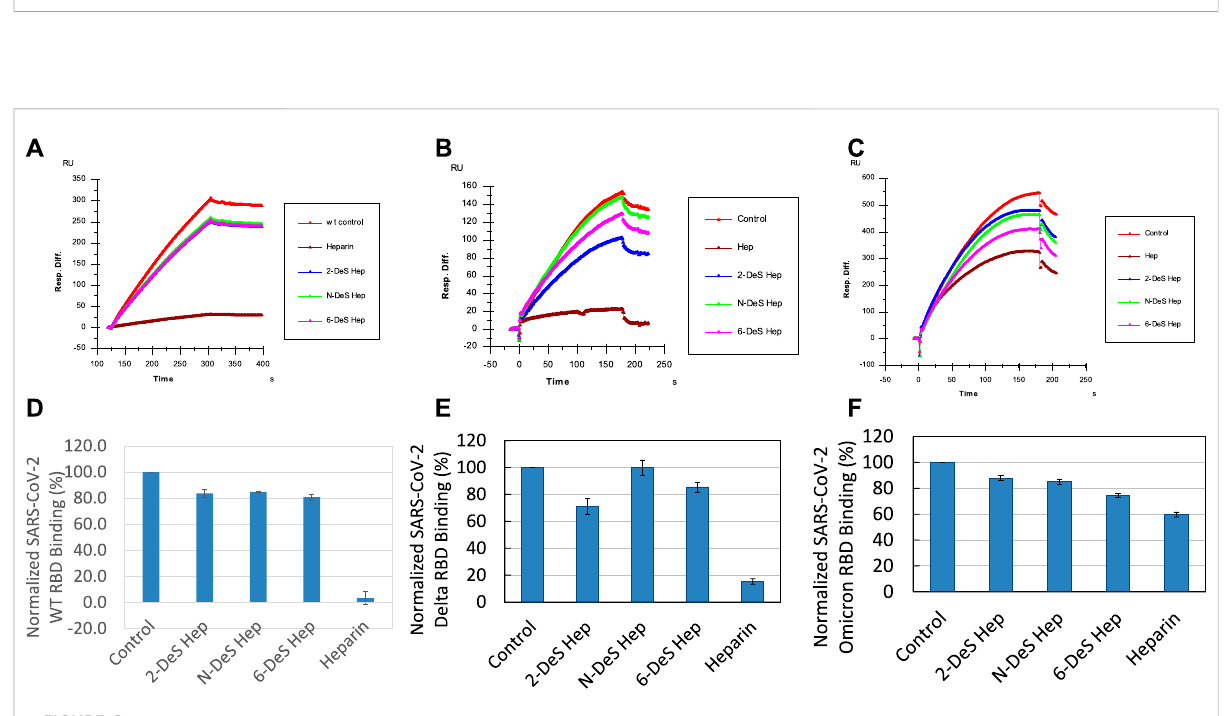
FIGURE 6 Sensorgrams and bar graphs (based on triplicate experiments with standard deviation) of normalized SGP-RBD binding to immobilized surface heparin;SGP-RBDwasmixedwithchemicallymodi fi edheparins(2- O -desulfated, N -desulfated,and6- O -desulfated)insolutionpriortoinjectionin direct binding competition with the surface heparin (A) WT; (B) Delta; (C) Omicron; (D) WT; (E) Delta; (F)